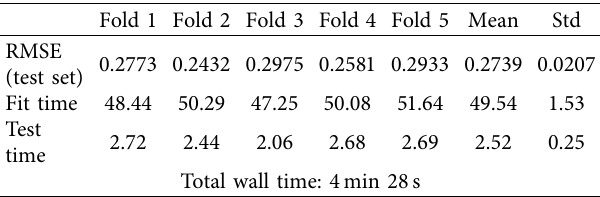
Figure 8: Te comparison of algorithms on MAE. Table 1: Evaluating RMSE of algorithm SVD on 5